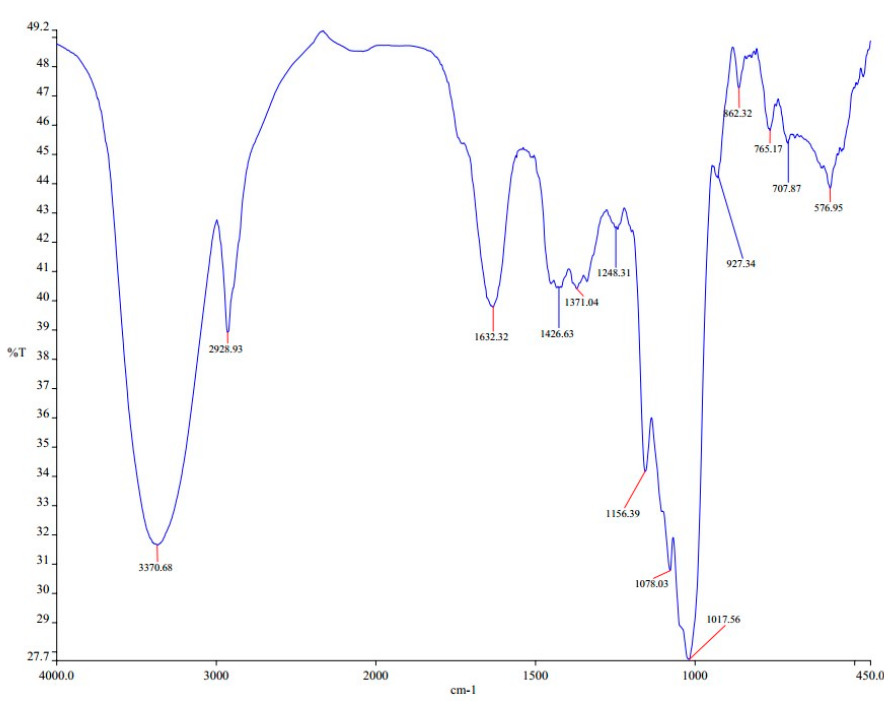
Figure 3. FTIR spectra for cassava peels.